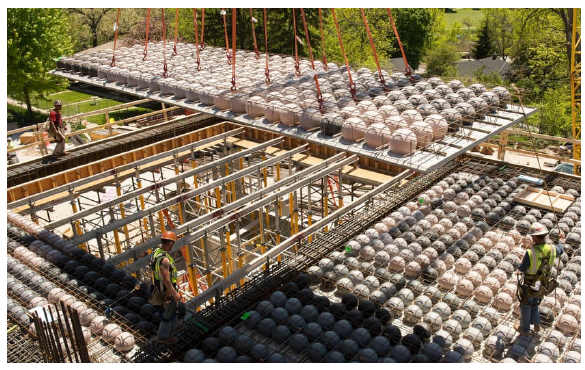
Figure 1. General view of residual formwork with plastic inserts [6].